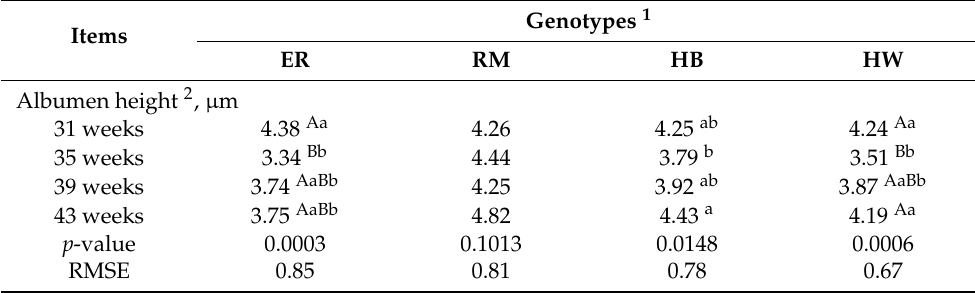
Table 6. Effect of age on albumen height and Haugh Units of stored 21 d eggs according to the genotype of the